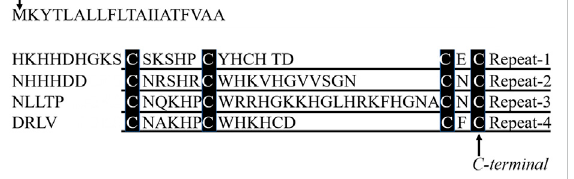
FIGURE 1 Four repetitive units in 20 kDa cement protein and peptides derived from the primary structure and sequence comparison of BalCP20-P3 and EGF-CBD. Four repetitive sequences in 20